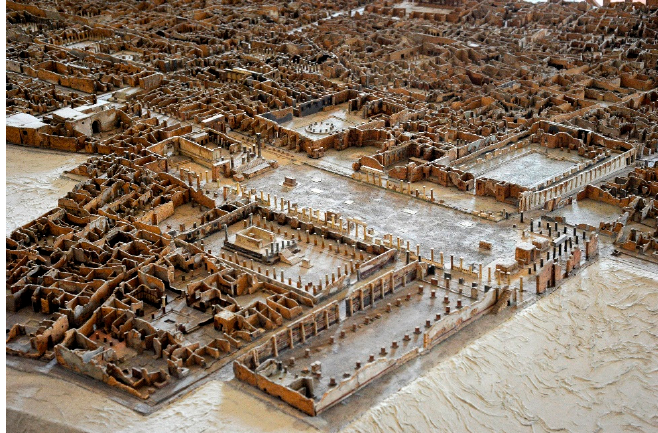
Figure 3. Plastico Pompeii. Image Courtesy: Prisma Archivo (used by permission).